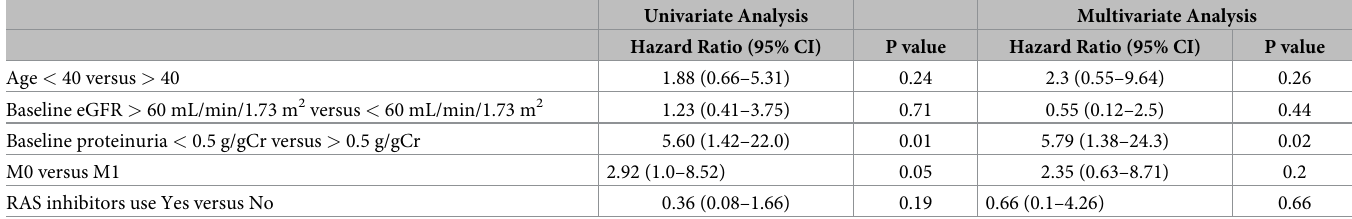
Table 3. Univariate and multivariate analysis of independent potential factors for remission of hematuria within 3 years.